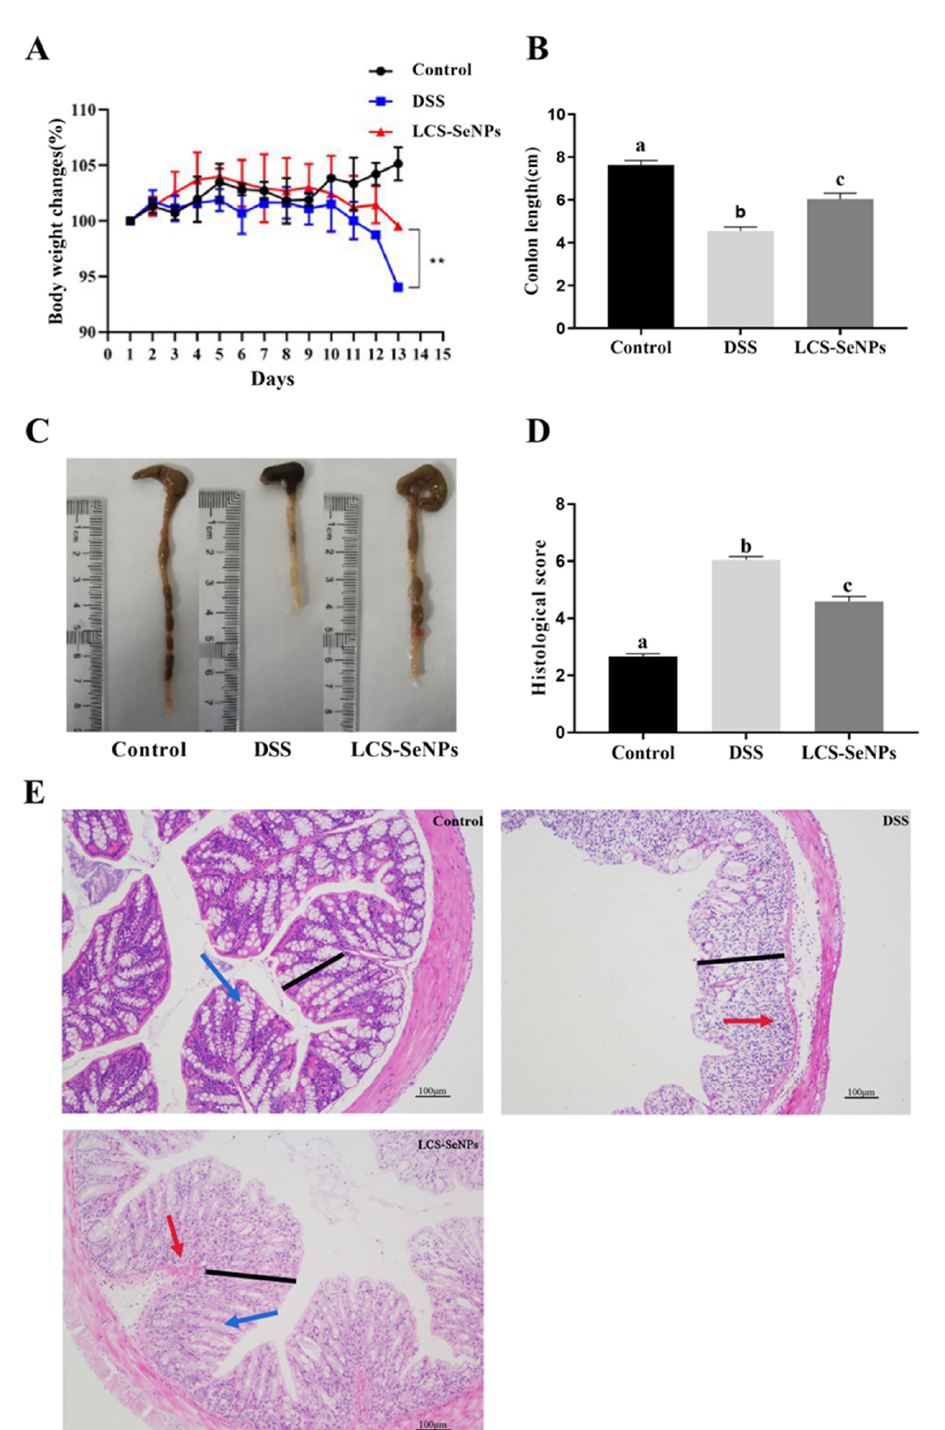
Figure 3. LCS-SeNPs alleviates DSS-induced colitis. Body weight change in mice ( A ); colon length in different groups ( B ); images of colon length from each group of mice ( C ); histological score ( D ); H&E staining images of each group, black line segment indicates mucosal layer, blue arrow indicates goblet cells and red arrow indicates inflammatory cells ( E ). Data are presented as mean ± SEM. In the same column values with different letters superscripts differ significantly (** p <